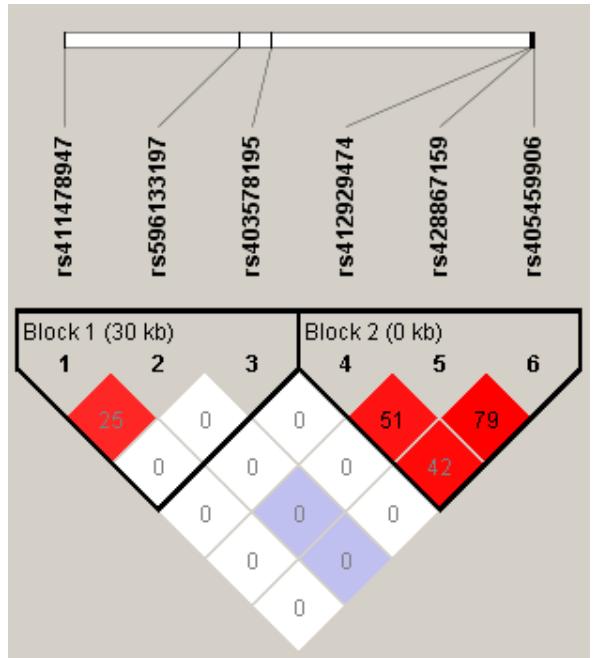
Figure 1. Linkage disequilibrium plot among the six non-conservative SNPs in LEPR using Haploview. The linkage disequilibrium colour scheme and values correspond with the D (cid:48) and r 2 parameters, respectively. Strong LD (D (cid:48) = 1, LOD ≥ 2) is indicated in red. Red indicates varying degrees of LD with lighter shades displaying less than darker shades (D (cid:48) < 1, LOD ≥ 2), and white indicates low LD (D (cid:48) < 1, LOD <